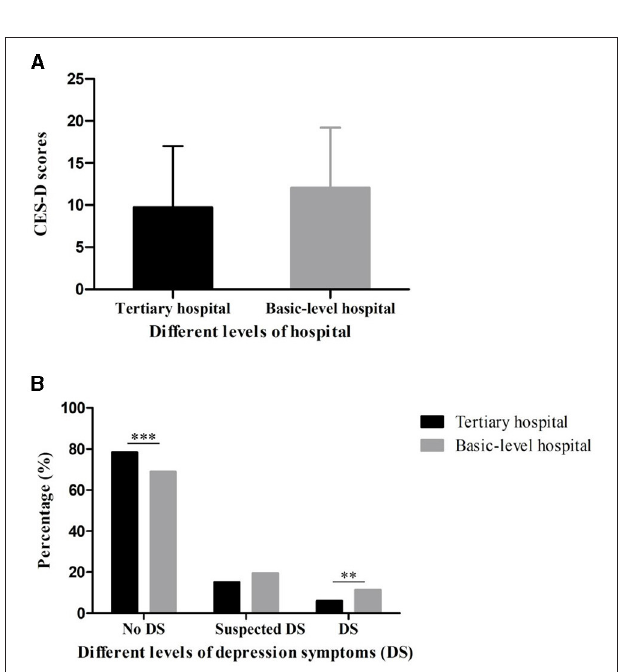
FIGURE 2 | CES-D scores (A) and different levels of depression symptoms (B) of medical staff in tertiary hospitals and basic-level hospitals during the break of COVID-19 (*** p < 0.001, ** p < 0.01).